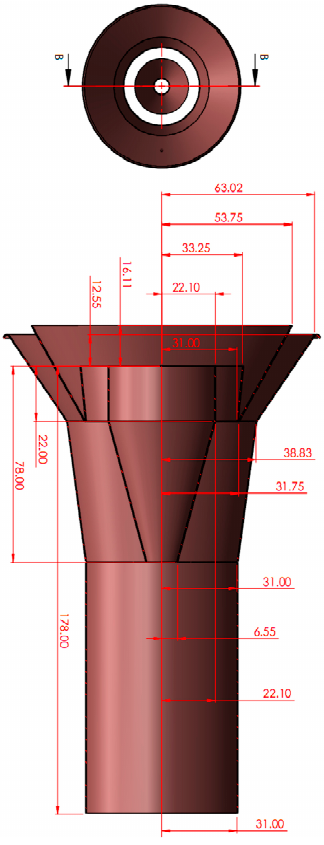
Figure 16. T he dimensions of the nozzle ejector. Figure 16. The dimensions of the nozzle